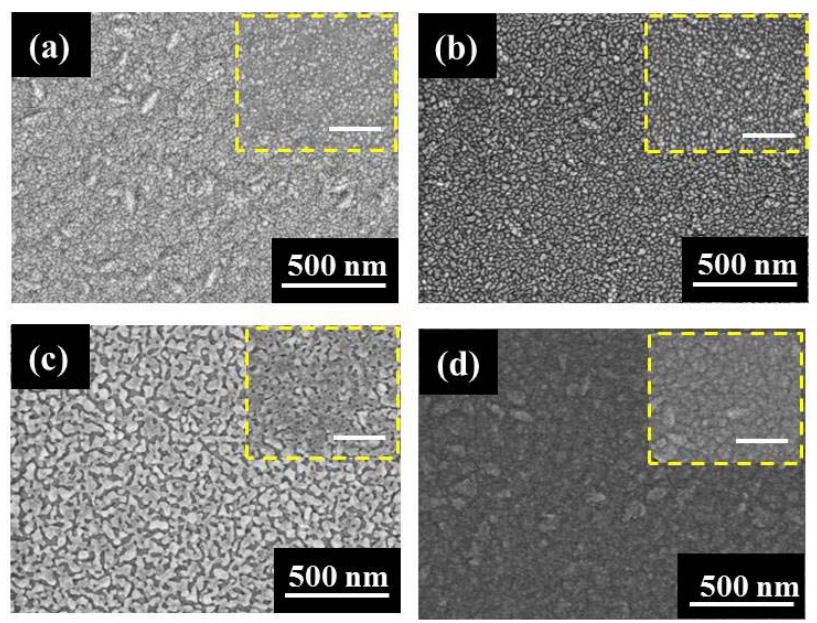
Figure 1. Conglobation of Ag nanofilms with various thicknesses with and without light illumination; ( a – d ) Ag nanofilms with thickness 5 nm, 10 nm, 20 nm and 30 nm, respectively, under light and under Al foil covers (insets). The scale bar in the inset is 250 nm.